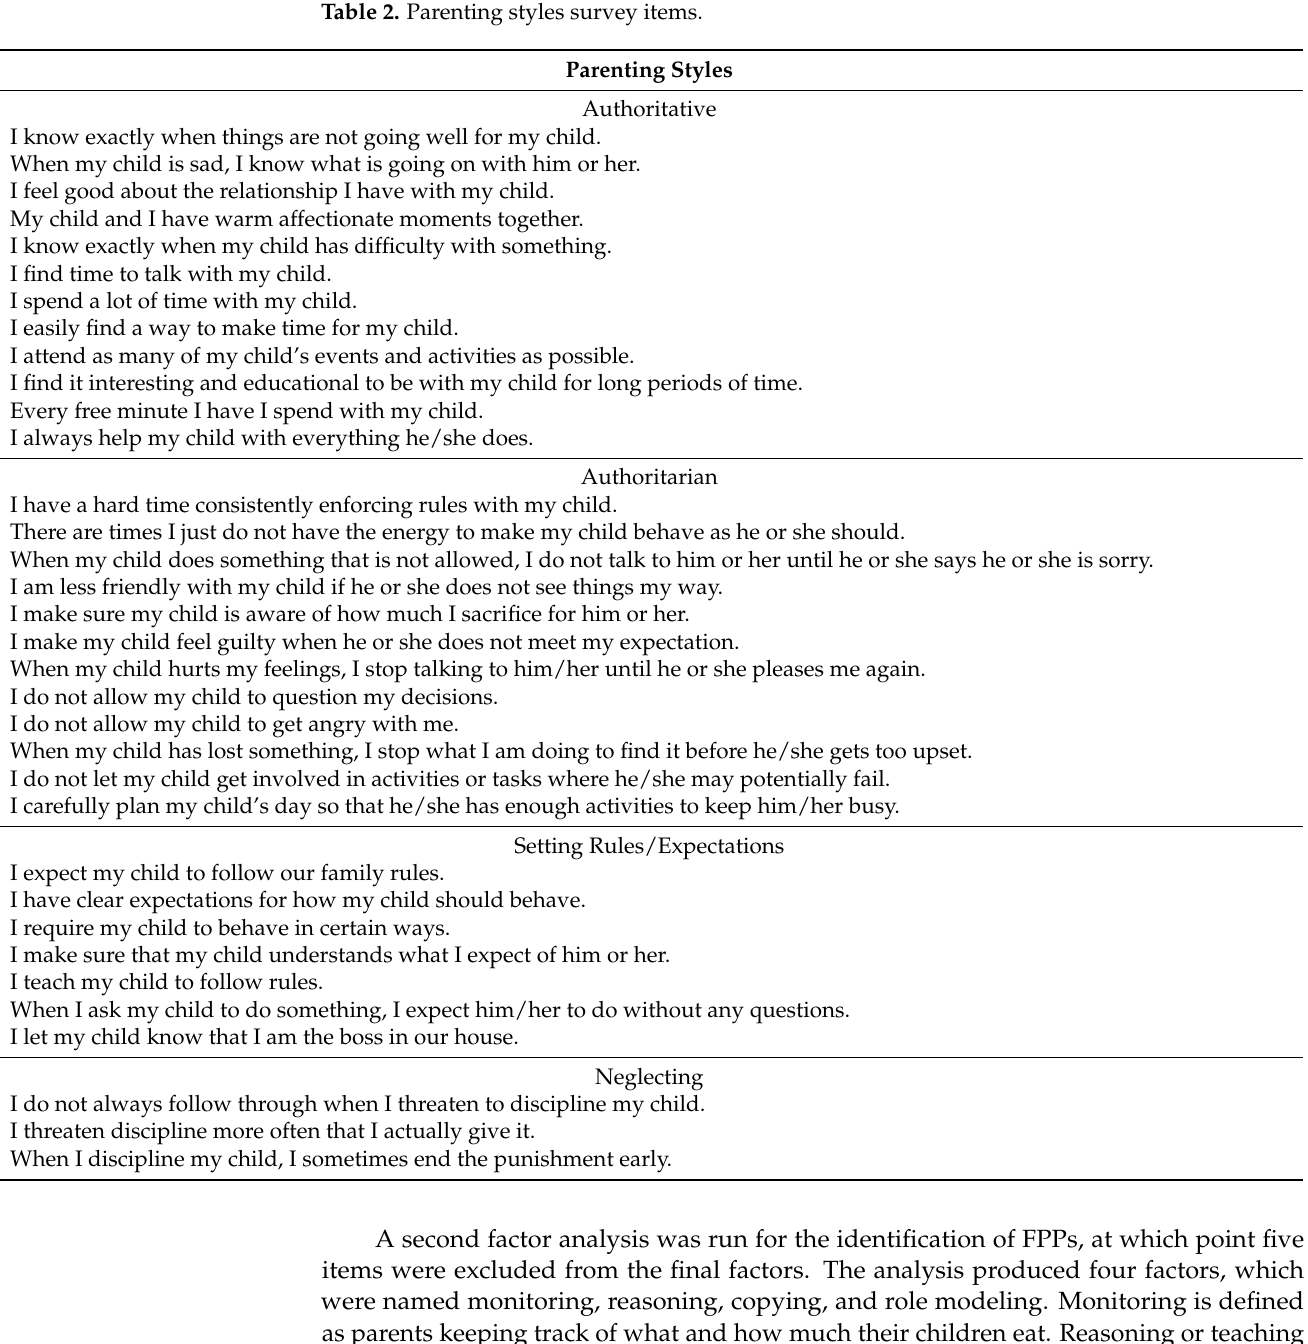
Table 2. Parenting styles survey